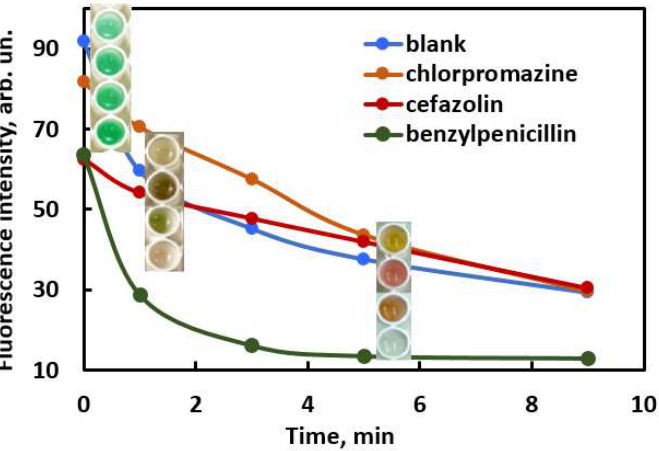
Figure 3. Kinetic curves of NIR fluorescence intensity of the dye 3 (obtained from NIR images) as a function of time for three model analytes (chlorpromazine, cefazolin, benzylpenicillin) and a blank experiment. Visual images of the four wells containing the analytes at times 0, 1, and 5 min are also shown. Conditions: phosphate buffer (pH 7.4), 0.5 mM analyte, 0.1 mM CTAB, 0.01 g/L dye 3, 0.1 M H 2 O 2 , 0.1 mM Cu 2+ .